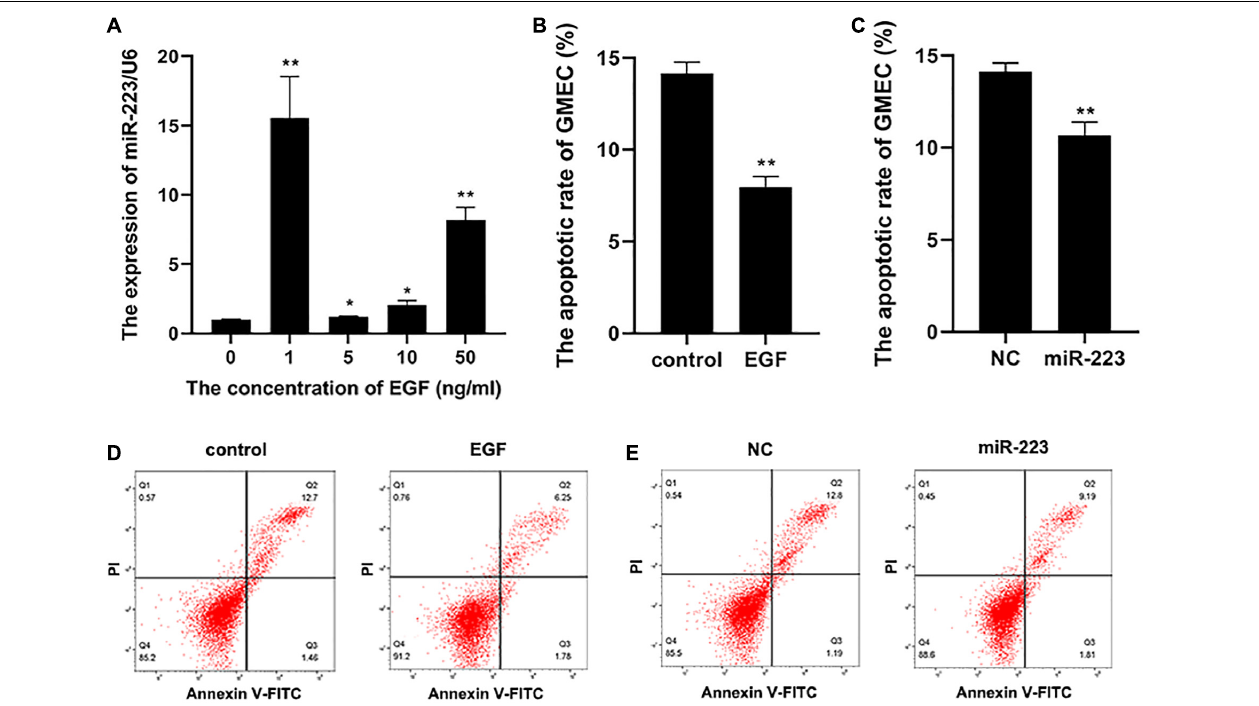
FIGURE 1 | The apoptosis of gMEC regulated by EGF and miR-223. (A) A higher expression of miR-223 was induced by EGF. The gMECs were incubated for 48 h with EGF at concentrations of 0, 1, 5, 10, and 50 ng/ml, respectively, and the expression of miR-223 was then detected, which revealed that the expression of miR-223 was the highest in gMEC incubated with 1 ng/ml of EGF. (B,D) The regulation of gMEC apoptosis by EGF. The cell cultivators with or without EGF at 1 ng/ml were applied to incubate gMEC for 48 h, and a reduction of apoptotic rate in gMEC was found in EGF group. (C,E) The regulation of gMEC apoptosis by miR-223. MiR-223 and NC were transfected into gMEC, respectively, and 48 h post-transfection gMEC apoptotic rate was found reduced in miR-223 group. * p < 0.05; ** p <